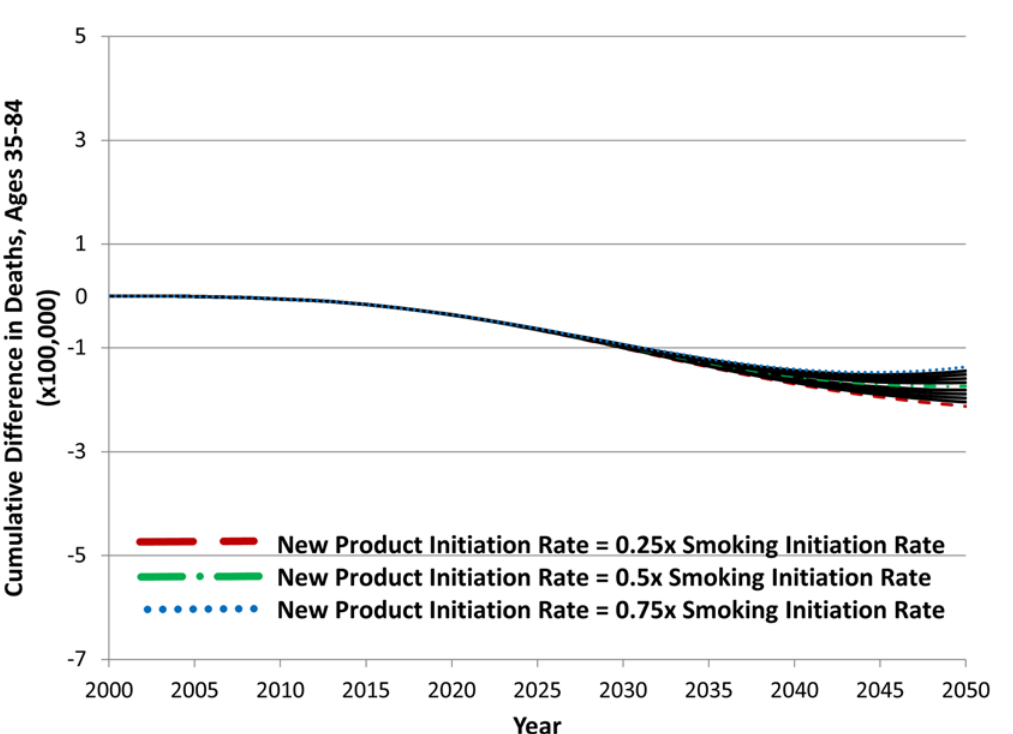
Fig 9. The effect of new product initiation rate values on cumulative difference in deaths between the status quo and hypothetical scenario A, 2000 – 2050.